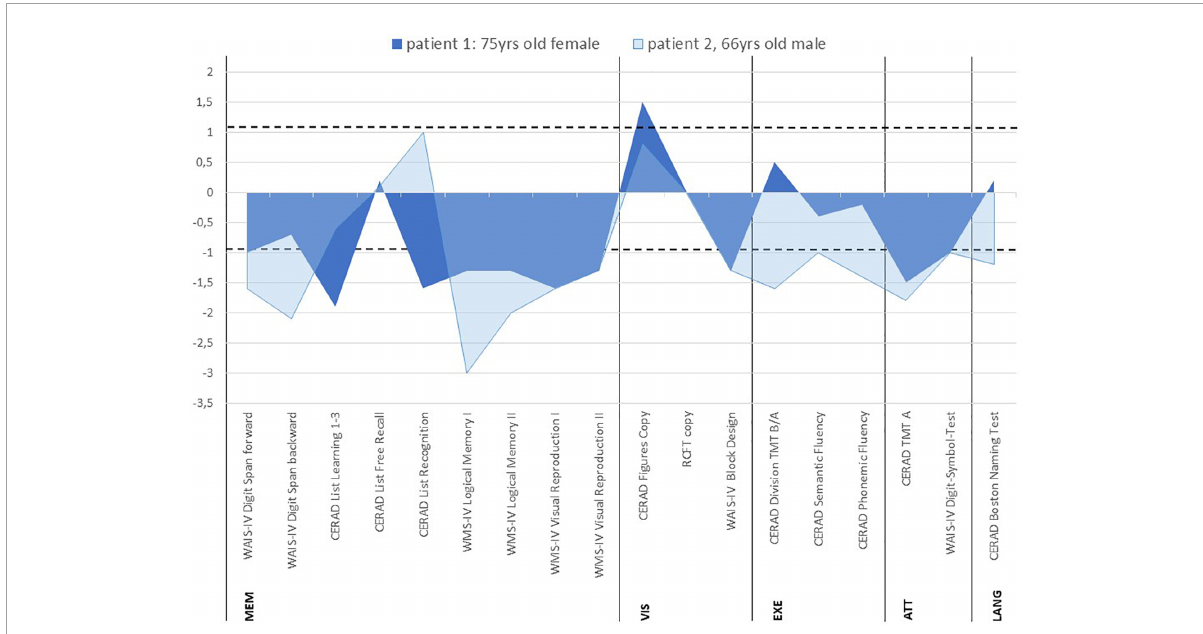
FIGURE1 Neuropsychological profiles of patients with anti-neurofascin 186 autoantibody-associated cognitive impairment z -scores. The area between dotted lines denote the normal range. CERAD, consortium to establish a registry for Alzheimer’s disease; WMS IV, wechsler memory scale – 4 th edition; RCFT, rey-osterrieth complex figure test; WAIS-IV, wechsler adult intelligence scale – 4 th edition; TMT, trail making test; MEM, memory; VIS, visuospatial cognition; EXE, executive functions; ATT, attention; LANG,